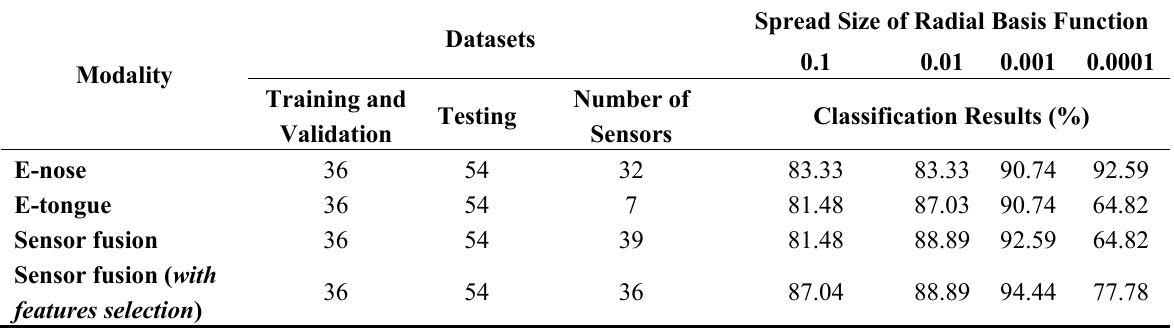
Table 7. PNN Classification